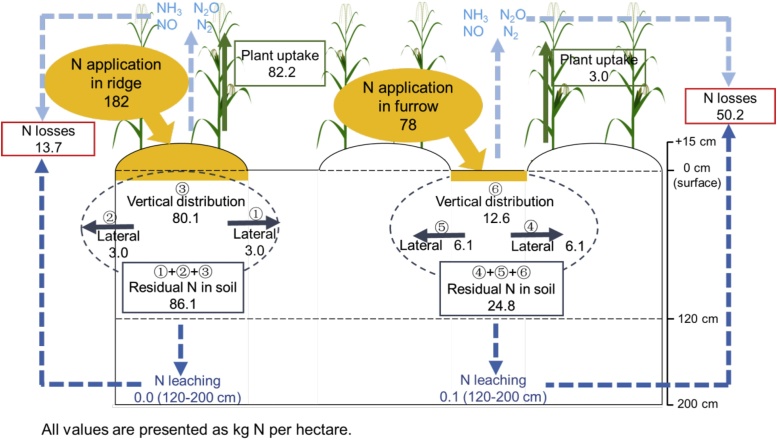
Distribution of fertilizer N (15N) in the 0–200 cm soil profile for the Plastic-Furrow and Plastic-Ridge components of the Plastic system at harvest in 2015 (all values are presented as kg N ha−1).